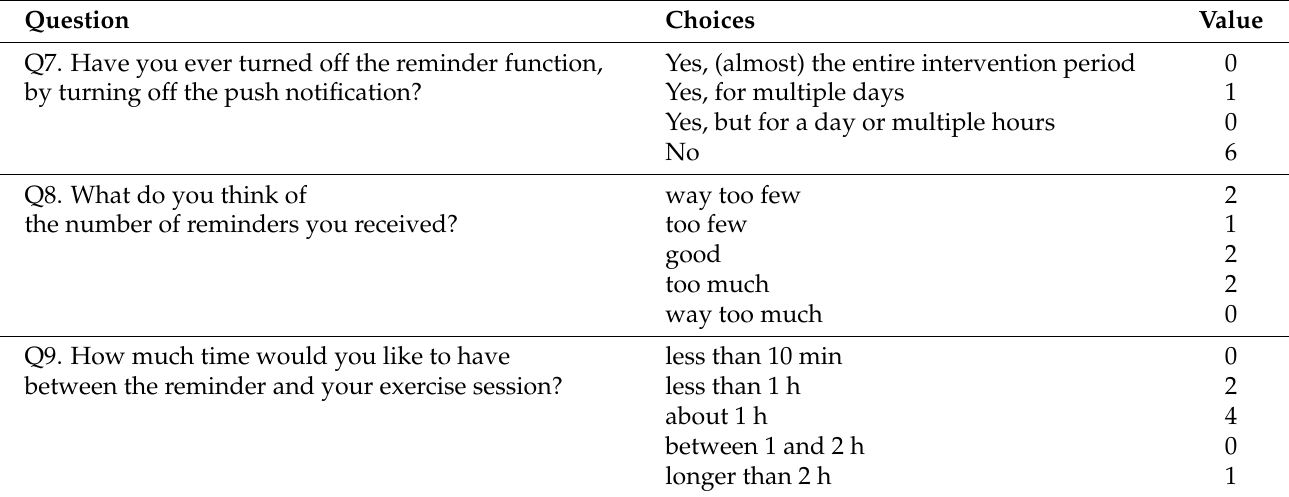
Figure 7. The results of the top 6 questions in the questionnaire, showing perceptions of the timing of reminders. Each unit on the X coordinate represents one participant. Table 4. The results of other questions in the questionnaire about reminder-related